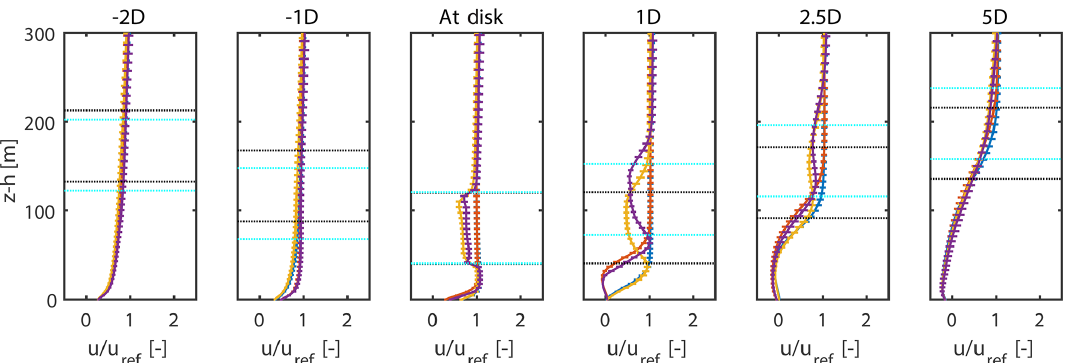
Figure 6. Vertical profiles of normalized mean streamwise velocity around first ridge for two different grid resolutions. Blue and yellow vertical lines show velocity profiles without and with turbine for 20m resolution, whereas red and purple vertical lines show profiles without and with turbine for 10m resolution. Black horizontal lines trace rotor top and bottom for the coarse grid resolution, whereas cyan horizontal √ N , where σ is the standard deviation and N is the number of lines trace the same for finer-grid resolution. The error bars correspond to σ/ 30min ensembles used.